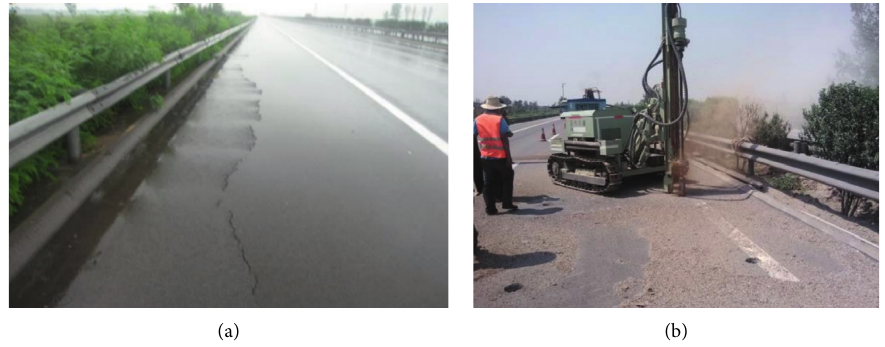
Figure 1: Longitudinal cracks and drilling rig operation at K555+800 (in Yinchuan direction).